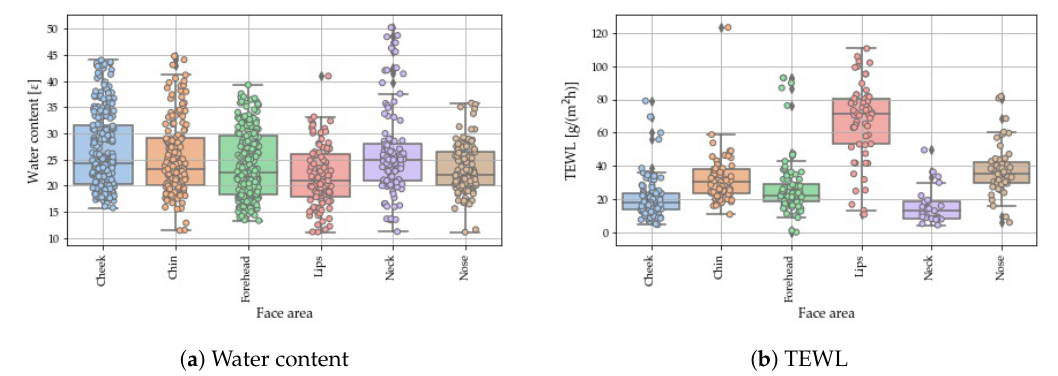
Figure 5. Box-plots/strip-plots showing the water content and trans-epidermal water loss at the six facial